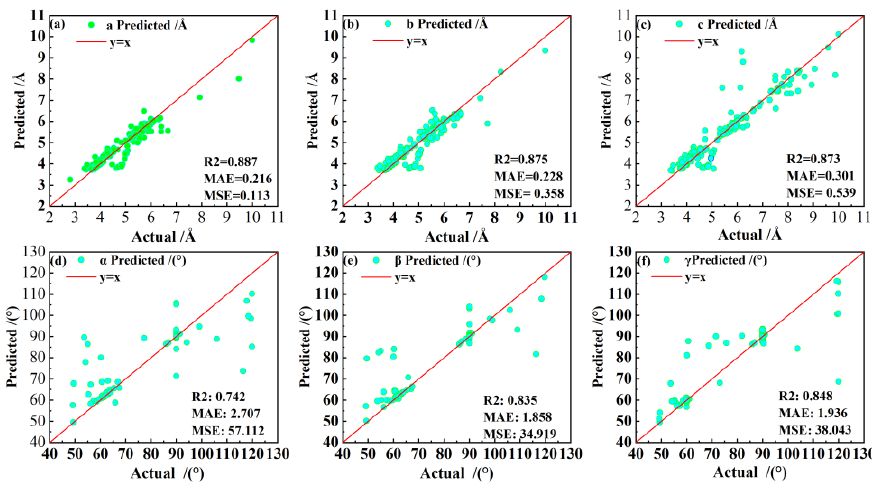
Figure 4. Predicted lattice constants of perovskite: ( a ) a; ( b ) b; ( c ) c; ( d ) α; ( e ) β; ( f ) γ .